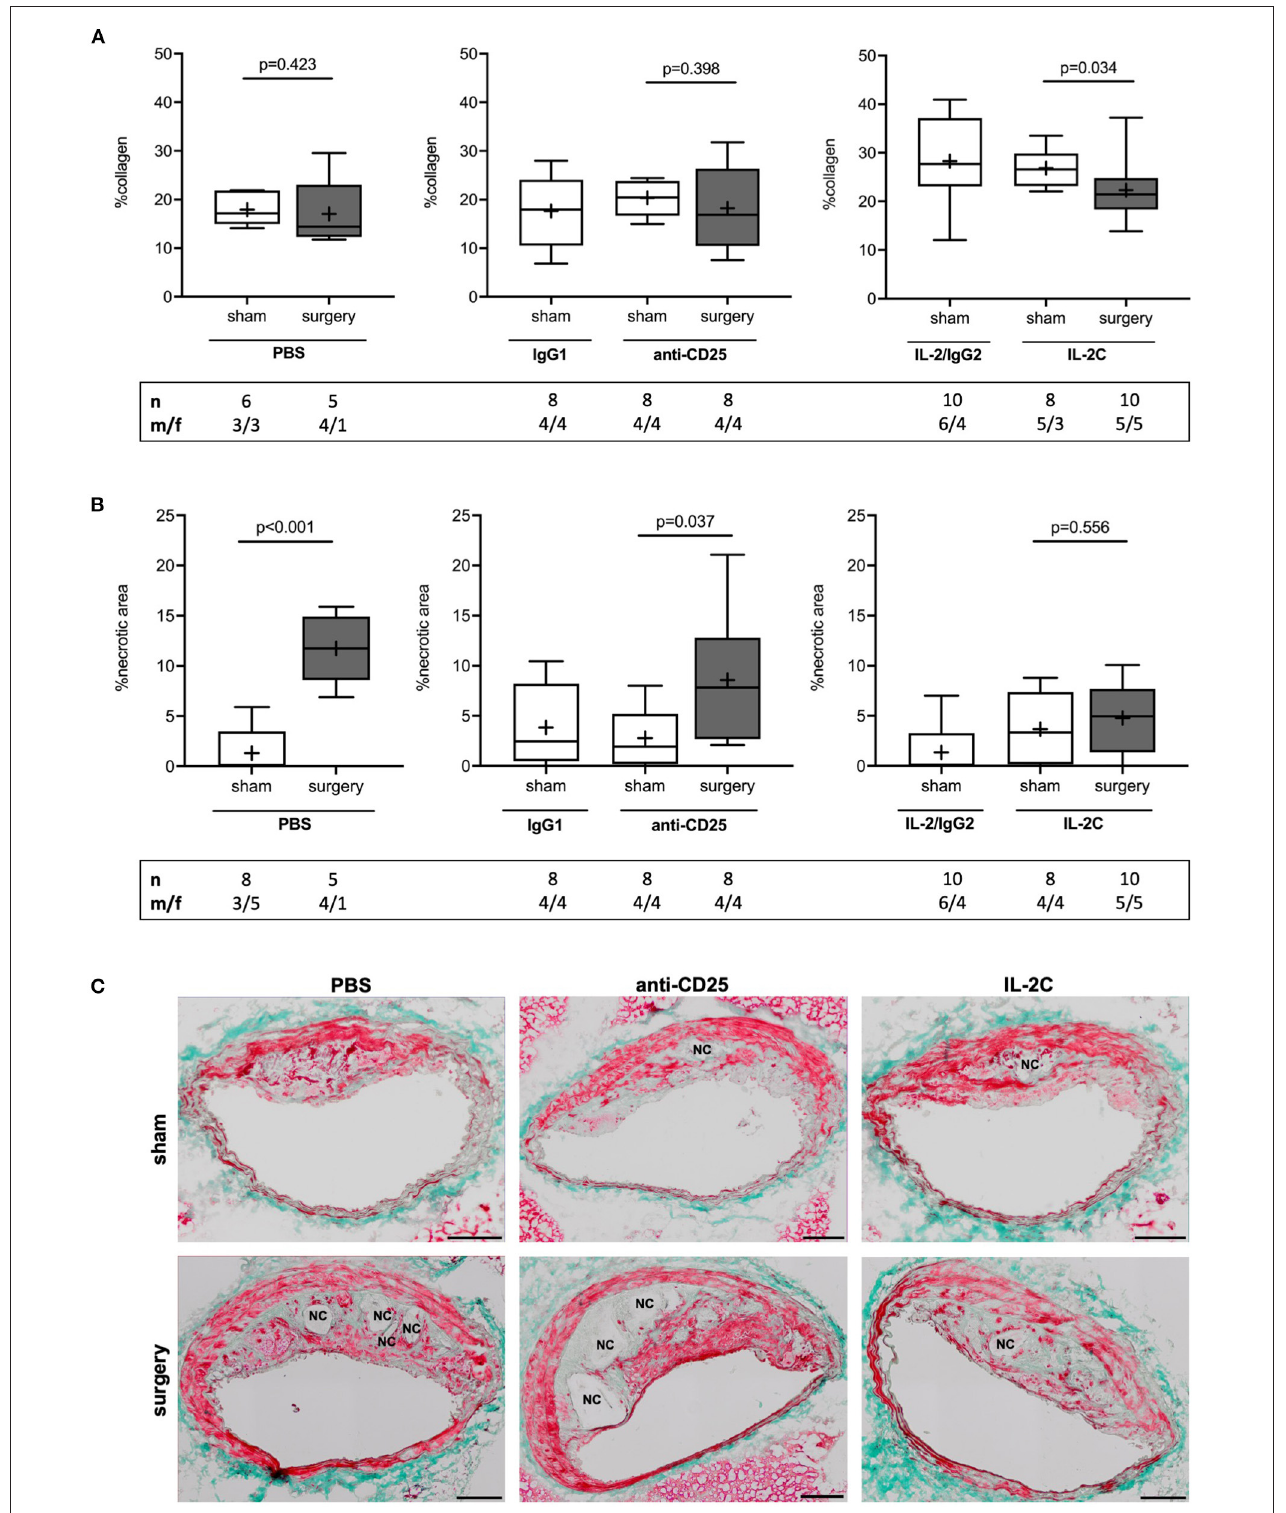
FIGURE 4 | Effect of preoperatively modulated Treg levels on atherosclerotic plaque collagen content and perioperative necrotic core formation. Cross-sections of the brachiocephalic artery were stained with Masson trichrome to quantify (A) collagen content and (B) necrotic area relative to total plaque area at the site of